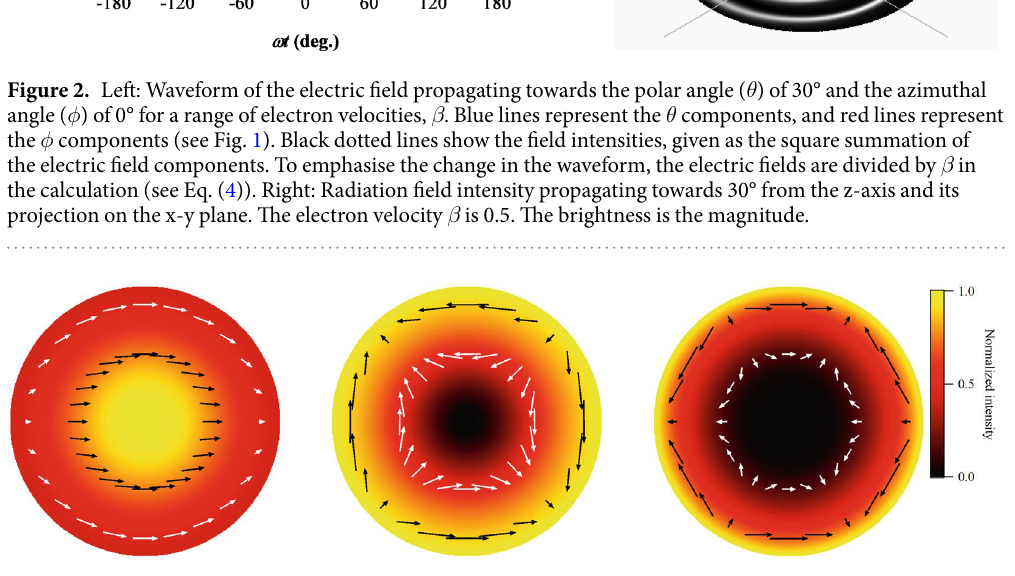
Figure 3. Electric field distribution in the upper hemisphere viewed from the z-direction (see Fig. 1), from left to right, for the fundamental ( l = 1), second ( l = 2) and third ( l = 3) harmonics calculated from Eq. (5). The colour represents the field intensity. The fundamental frequency has an intensity maximum in the centre, whereas the harmonics show zero intensity at the centre. Arrows represent the direction of the electric field at a specific